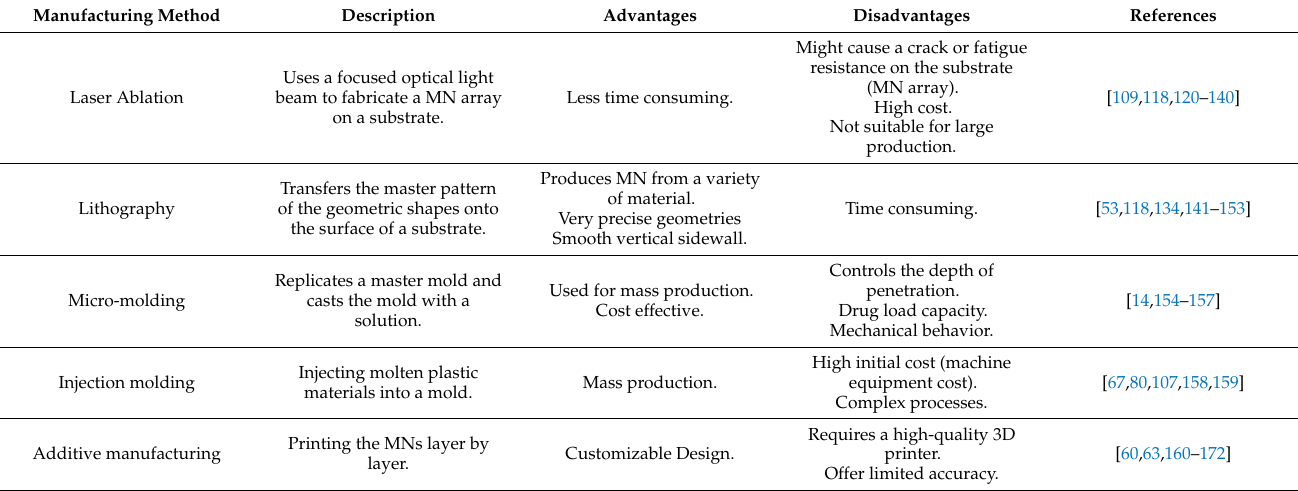
Table 3. Overview: MN Manufacturing